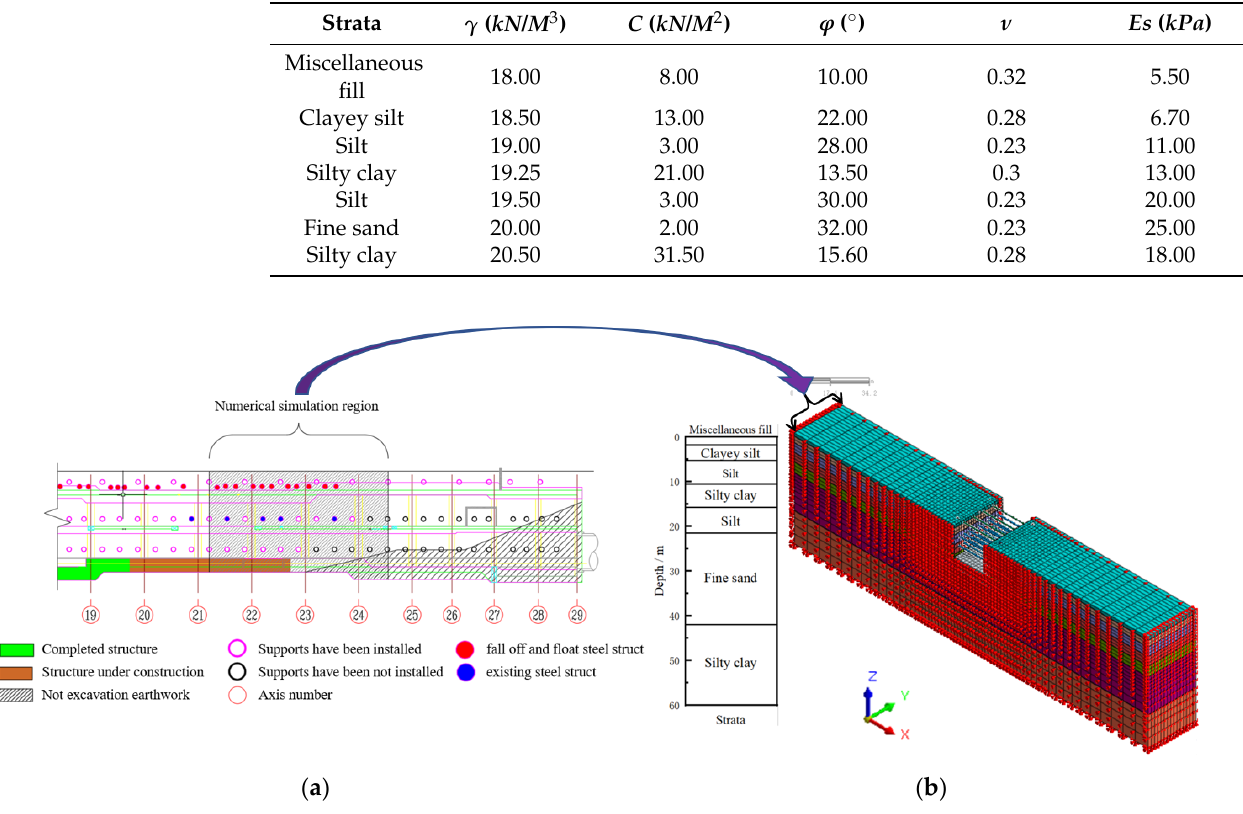
Figure 4. Calculation model and steel strut distribution diagram. ( a ) Distribution map of the existing support and shed support. ( b ) Calculation model.